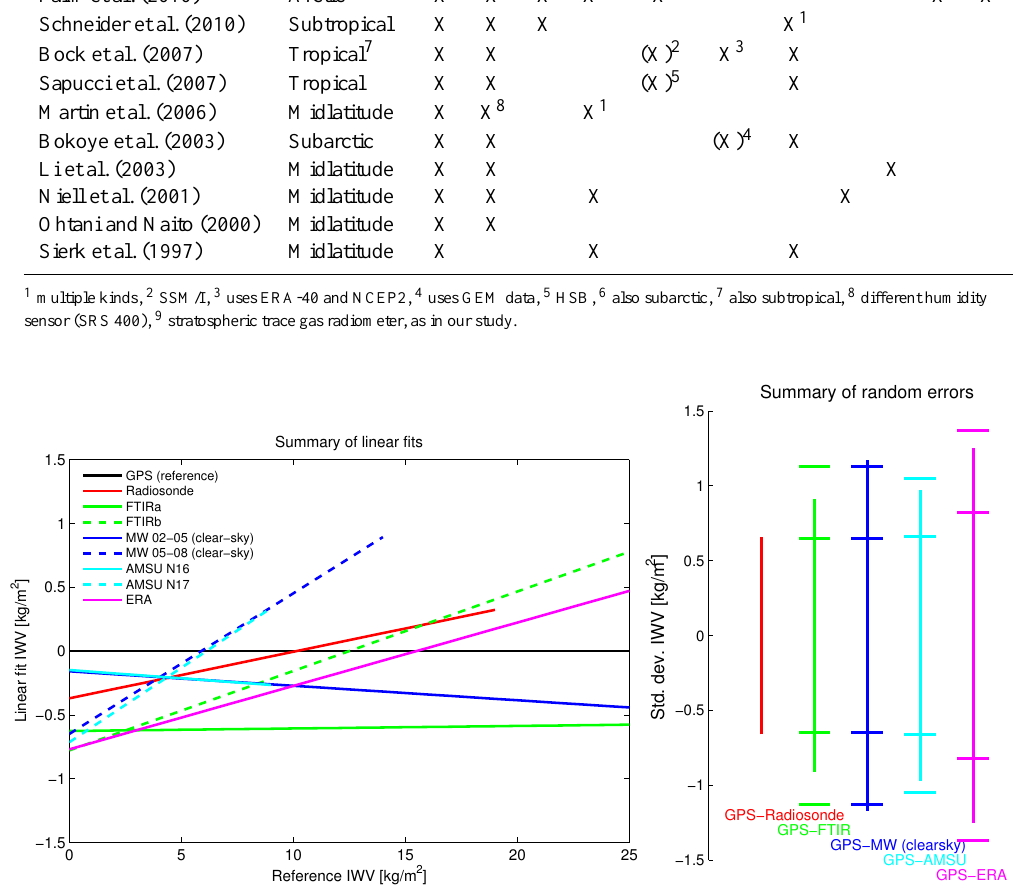
Fig. 9. Systematic and random differences for all datasets relative to the GPS dataset. Left plot: difference of linear regression lines (same data as in Table 4) from the diagonal. Lines are only plotted over the IWV range where we have data. Right plot: standard deviation of the difference to the GPS (vertical bars, same data as in Table 4) and minimum and maximum NICAM estimate of the representativeness error (horizontal lines, same data as in Table 3). For datasets where we have several versions, we somewhat arbitrarily selected one set to represent the technique for the random error plot, namely FTIRa for FTIR, MW 02-05 for microwave, and N17 AMSU-B for